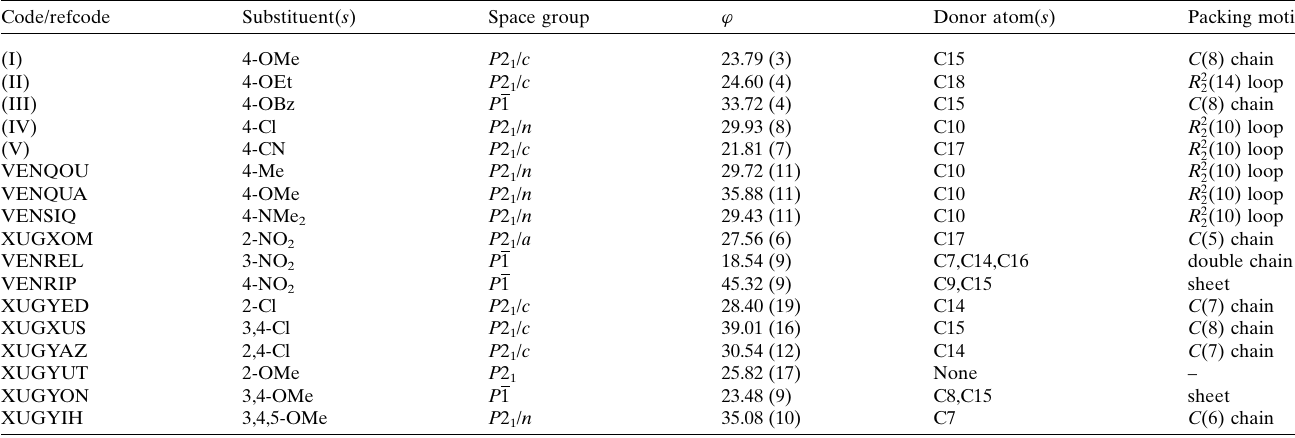
Table 7 Summary of the C—H (cid:3)(cid:3)(cid:3) O and C—H (cid:3)(cid:3)(cid:3) N hydrogen bonds and packing motifs for 2-(benzylidene)benzosuberone derivatives.